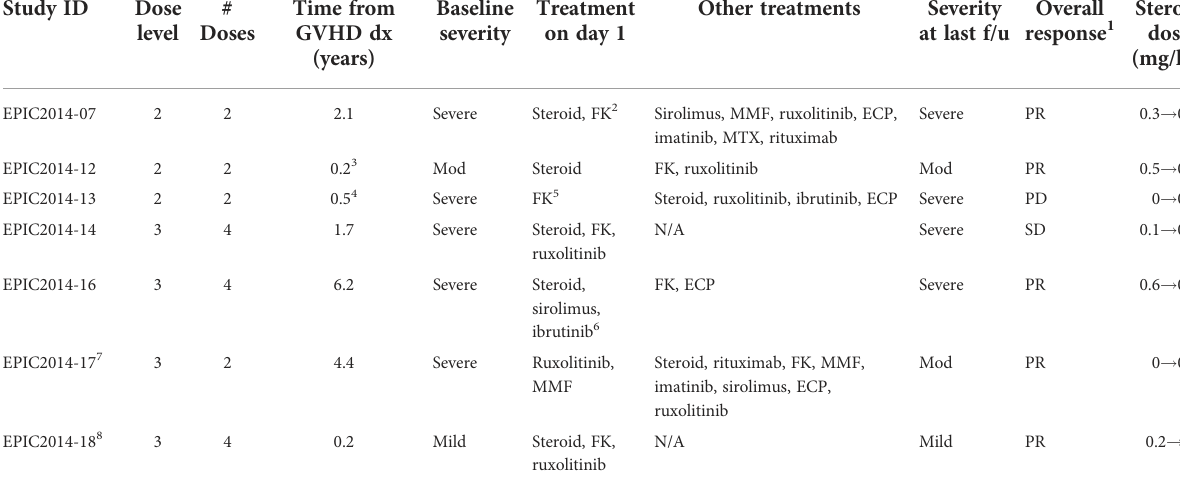
TABLE 3 Chronic GVHD characteristics and response following autologous MSC infusion. Study ID